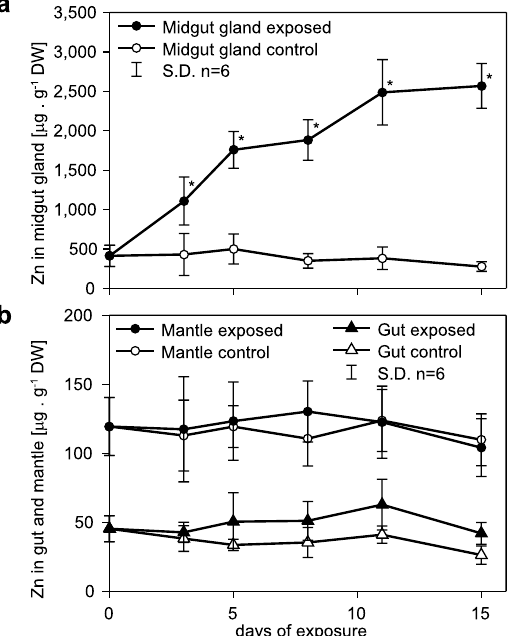
Figure 1. Zinc concentrations (means and standard deviations, n = 6) expressed in µ g per g dry weight, shown in organs of slugs exposed to Zn over a period of 15 days. ( a ) Course of Zn concentrations through 15 days in midgut gland of control (open circles) and Zn-exposed slugs (full circles). ( b ) Zn concentrations through 15 days in gut (triangles) and mantle (circles) of control (open symbols) and Zn-exposed slugs (full symbols). The asterisks above single values indicate significant differences compared to respective control values (Holm–Sidak method of all pairwise multiple comparison) (p ≤